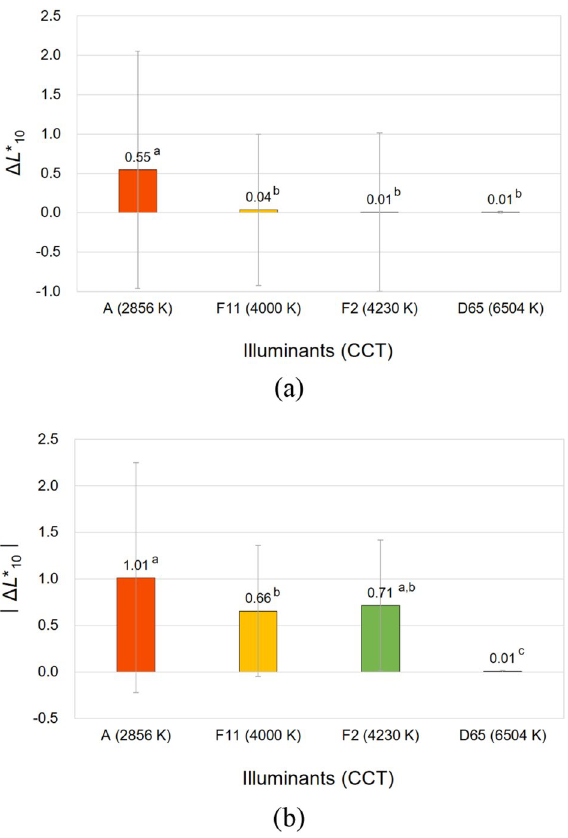
Figure 7. Effect of the correlated color temperature (CCT) of illuminants on the lightness appearance change, ( a ) Δ L * 10 and ( b ) | (cid:31) L ∗ 10 | , of samples. (Δ L * 10 = L * A under the illuminant—spectrophotometrically measured L * 10